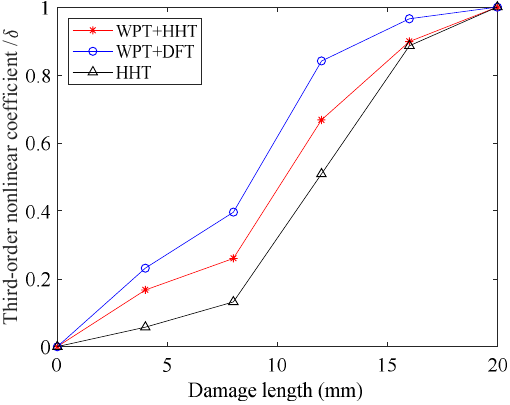
Figure 16. The changing curves of a normalized third-order nonlinear coefficient.